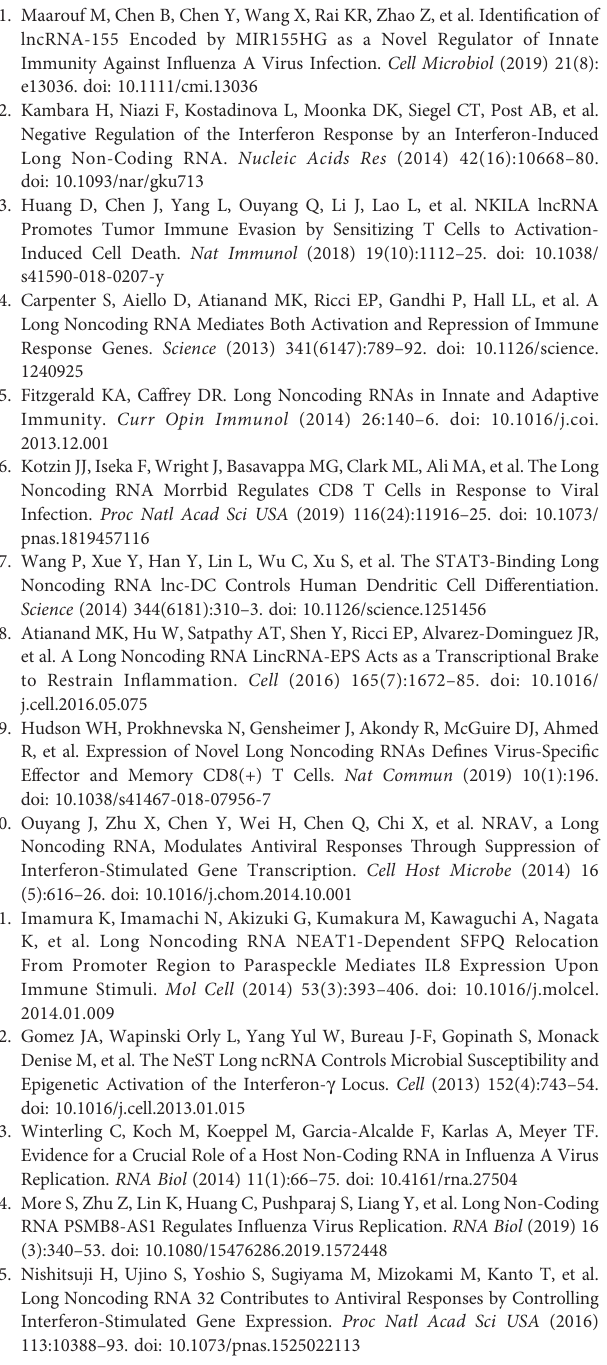
Supplementary Figure 8 | The mechanisms of RDUR in antiviral innate immunity. The schematic diagram of